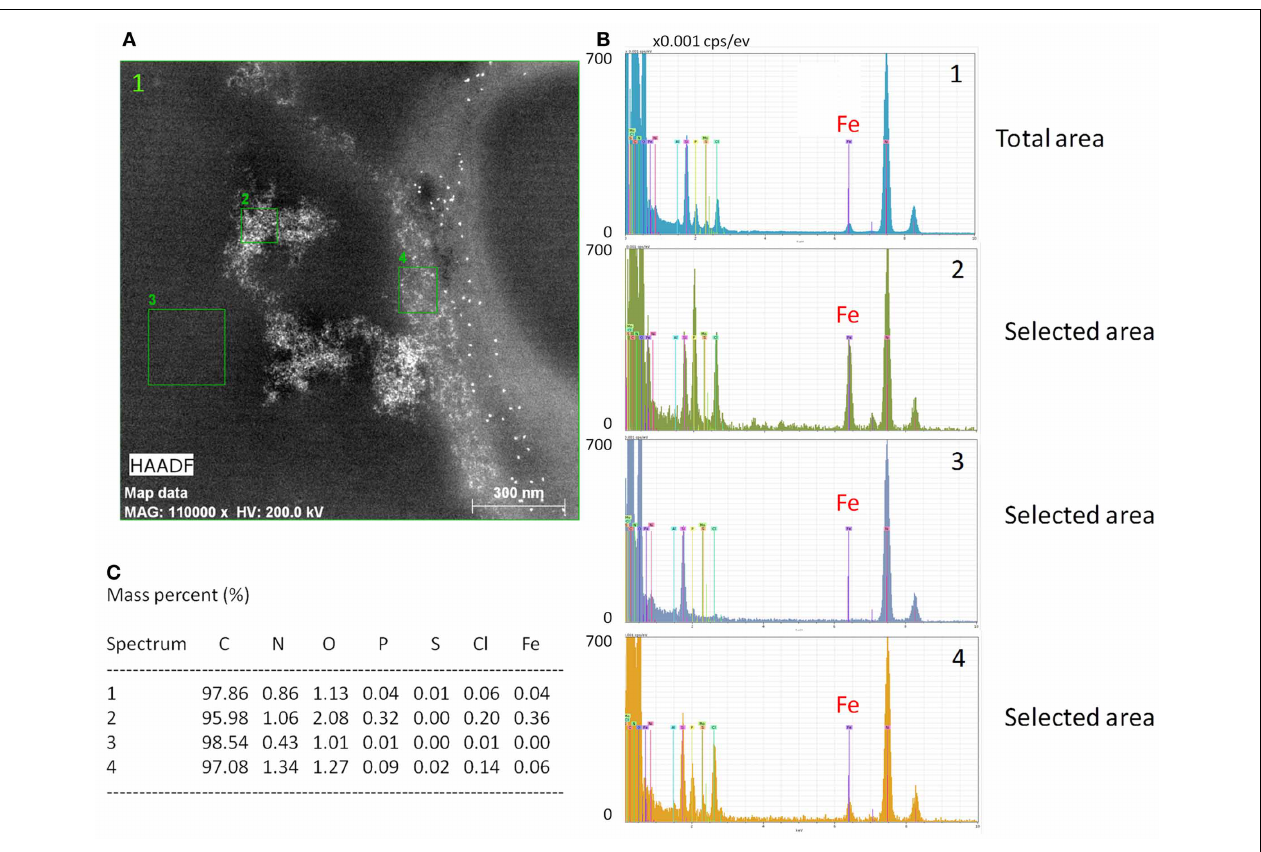
FIGURE 2 | Intracellular iron detection with EDX. (A) Energy dispersive X-ray analysis of a representative image showing intracellular cytoplasmic iron in a CD3 + cell. White represents iron. Numbered areas analyzed for elemental composition; “1” represents the total area depicted. (B) Elemental composition of the four areas depicted in (A) with the peak